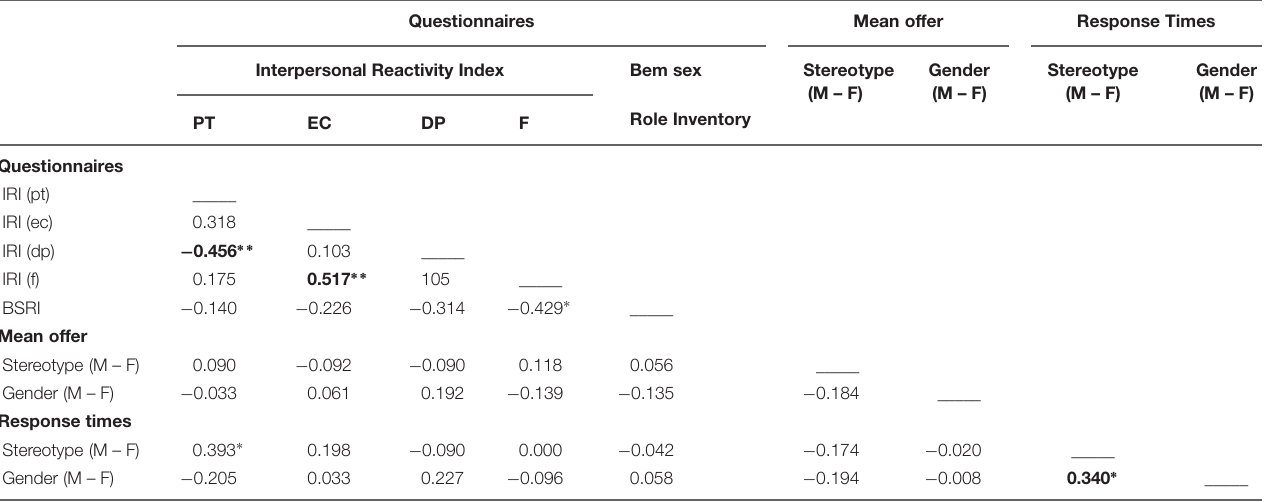
TABLE 2 | Correlations between the questionnaires’ scores and the differences in mean offers and response